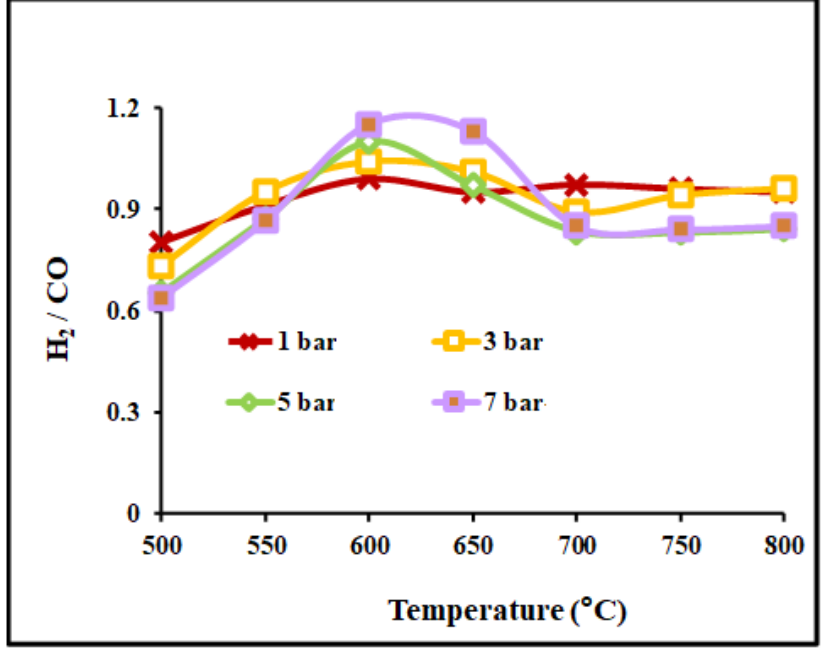
Figure 6. Catalytic activities of perovskite catalyst calcined at 725 ◦ C, activated at 750 ◦ C, using 0.05 g of catalyst and CH 4 : CO 2 :N 2 = 30 / 30 / 10 mL / min at GHSV of 84000 mL / g / h at T = 500–800 ◦ C. E ff ect of hydrogen and carbon monoxide ratios.